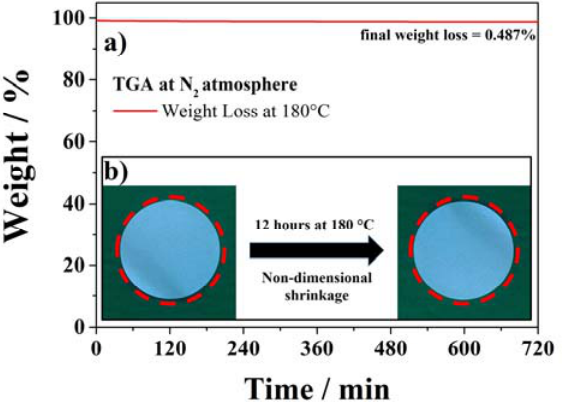
Figure 5. Thermal stability test of SiO 2 –HPG membrane at 180 °C for 12 h ( a ) TGA measurement; ( b ) dimensional-shrinkage